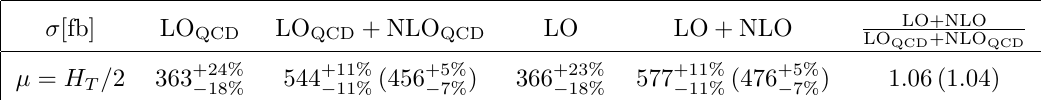
Table 1 . Cross sections for t (cid:22) tW (cid:6) production at 13 TeV in various approximations. The numbers in parentheses are obtained with the jet veto of eq. (3.6) applied.